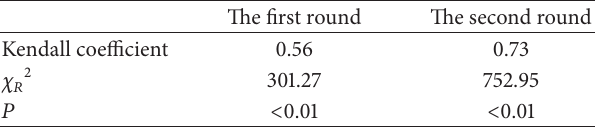
Table 2: Description of statistical analysis of experts ( 𝑛 = 22 ). Table 3: Kendall’s 𝑊 and Chi-squire test of